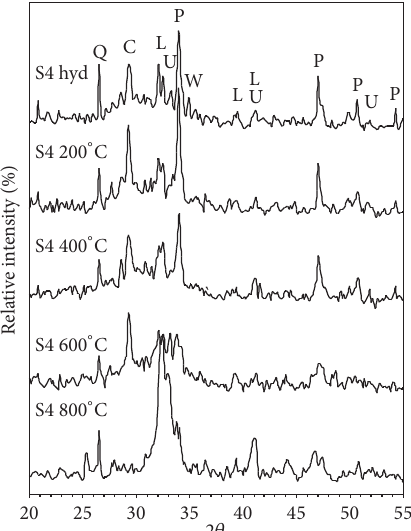
F 10: e XRD patterns of sewage sludge ash blended